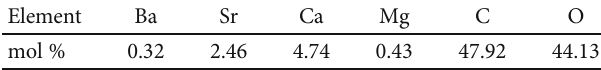
Figure 5: SEM pictures of crystalline phases of precipitation. Table 4: Content of elements in